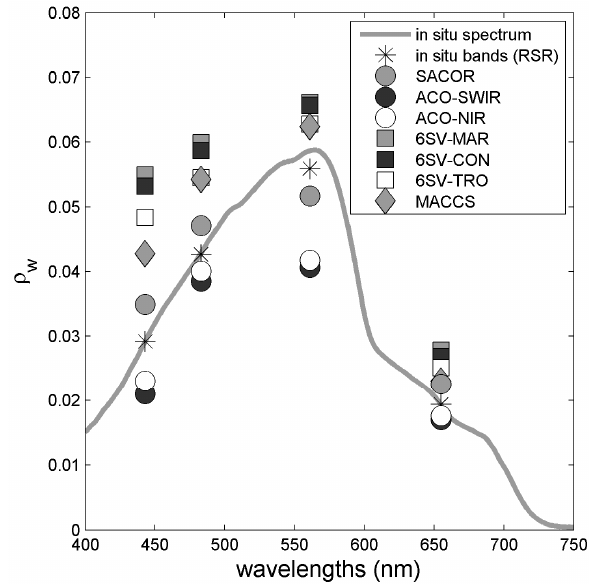
Figure 10. Comparison between the atmospherically corrected OLI image (bands 1, 2, 3 and 4) and in-situ ρ w (B13 station, see Figure 3) acquired on 2015-10-20. Symbols are associated with the different AC approaches. Note the cross markers are associated with the RSR-adjusted in-situ ρ w values.